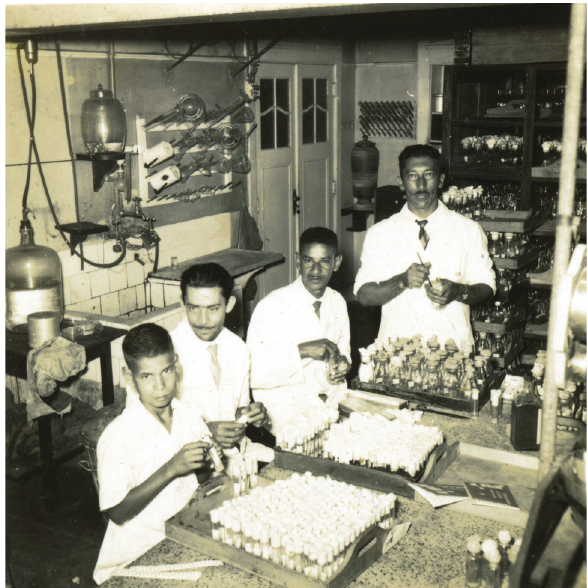
Figure 3 - Laboratory where culture medium was prepared at the Depart- ment of General Biology of the FFCL-USP, probably in 1956. Left wing of the attic of the Jorge Street Mansion. From left to right: the laboratory technicians Rubens Monteiro, Ramiro Gomes, Pedro Monteiro and Ga- briel do Prado Bueno (archives of the Memory Committee of the Departa- mentodeGenéticaeBiologiaEvolutiva